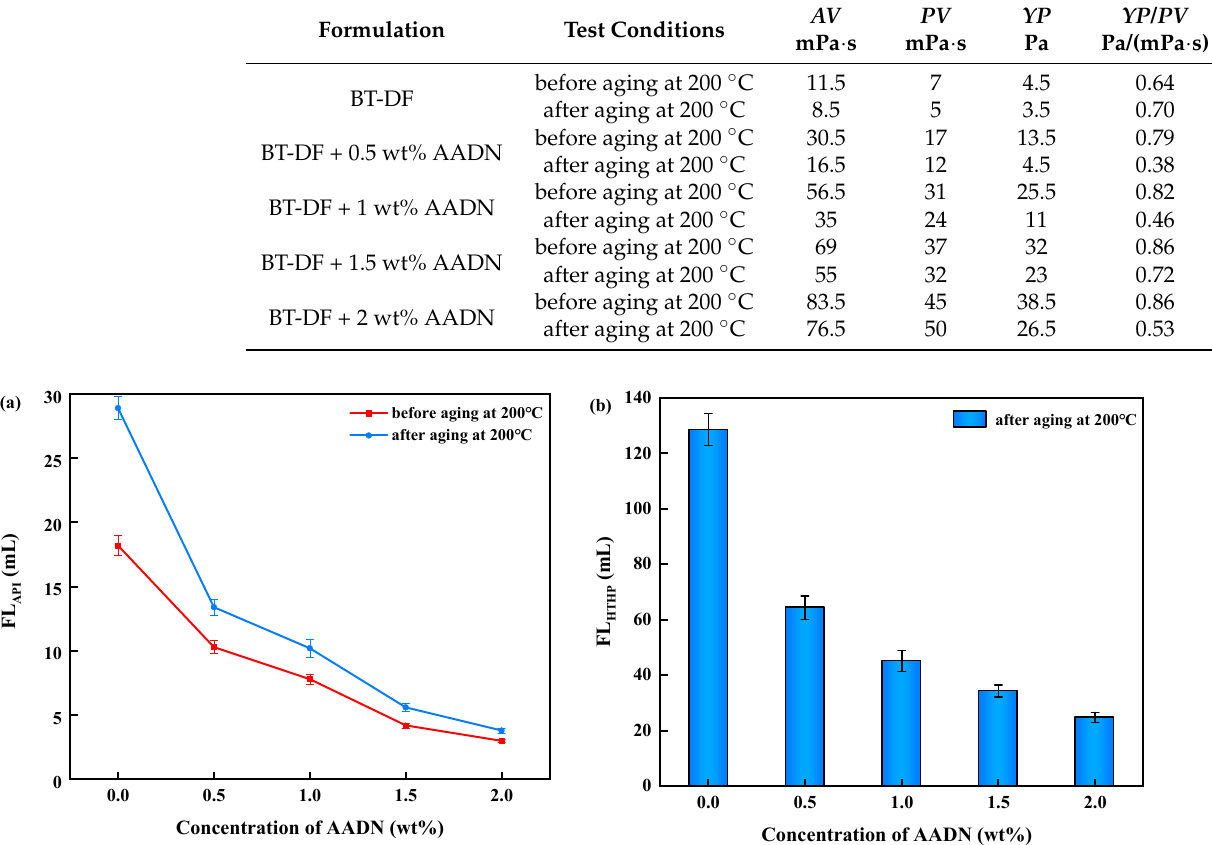
Table 3. The rheological properties of BT-DF with different AADN concentrations.